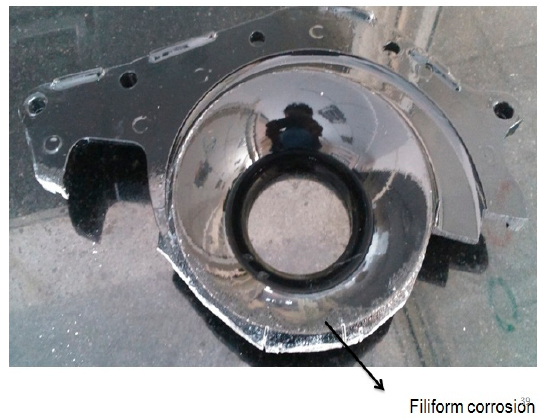
Figure 10. Acrylic paint ED coat.